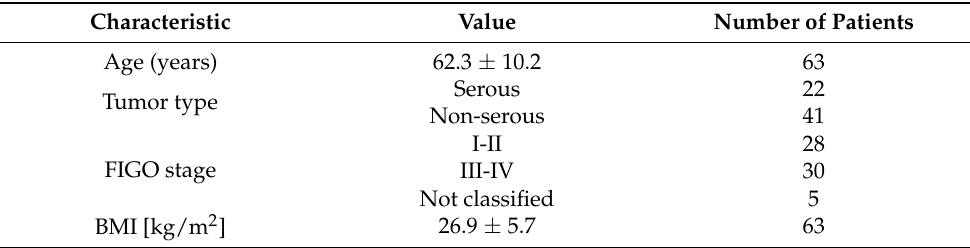
Table 1. Demographic and clinicopathological characteristics for the enrolled ovarian cancer patients.